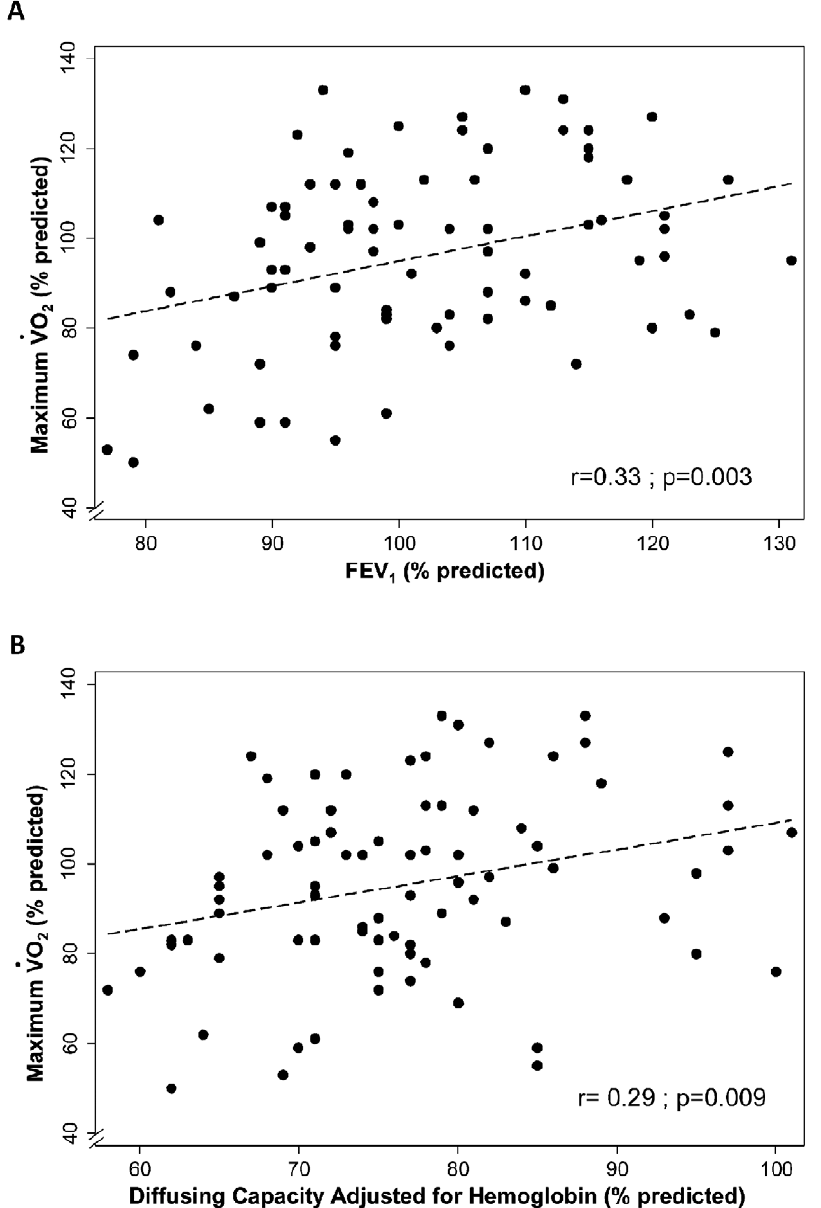
Figure 1. Association between exercise capacity and airflow and diffusing capacity in pre-ban FAs. The exercise capacity as estimated by maximum oxygen uptake (VO 2 ) was directly associated with ( A ) FEV 1 (r=0.33; p=0.002) and with ( B ) diffusing capacity at rest (r=0.29; p=0.008); r: correlation coefficient.